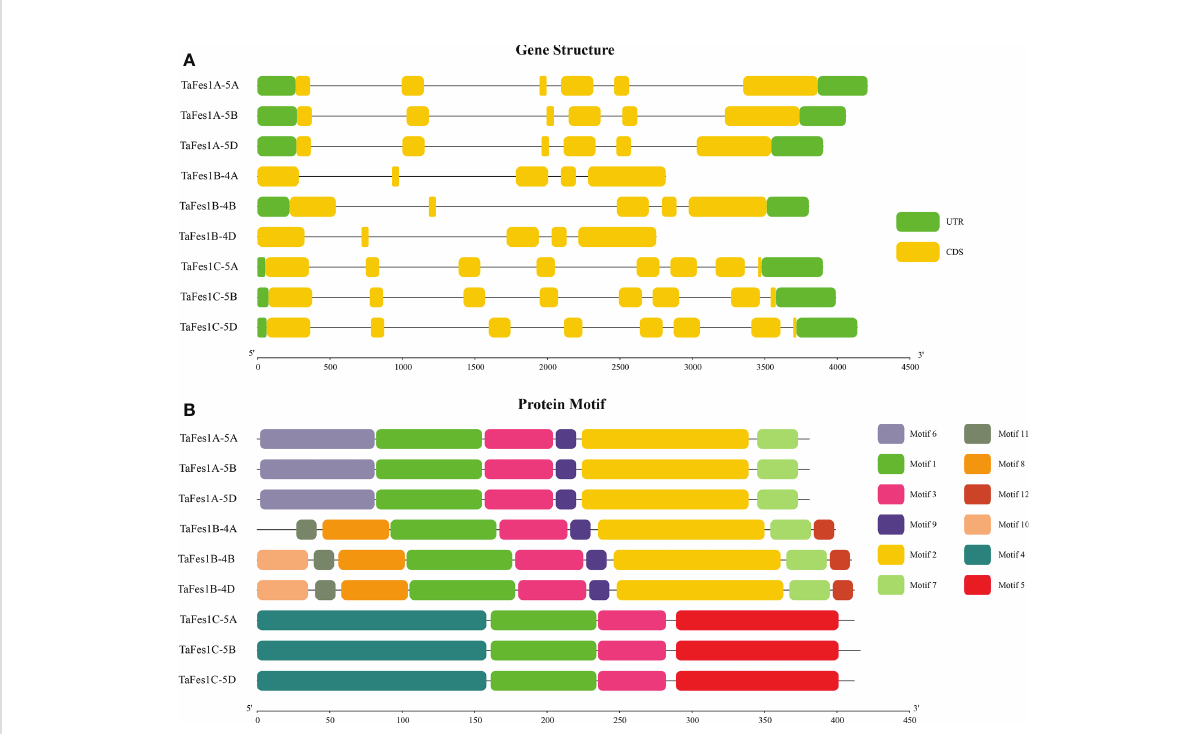
FIGURE 2 Gene structures and protein motifs of TaFes1s. (A) Gene structures of TaFes1s . Green boxes represent untranslated regions (UTR), yellow boxes refer to coding sequences (CDS), lines mean introns. The scale in bottom indicates gene length in base pairs unit. (B) Protein motifs of TaFes1s. Motifs are identi fi ed by MEME. Different motifs are shown in different colors, lines are protein sequences which none conserved motif is characterized. The scale in bottom indicates protein length in amino acid unit.